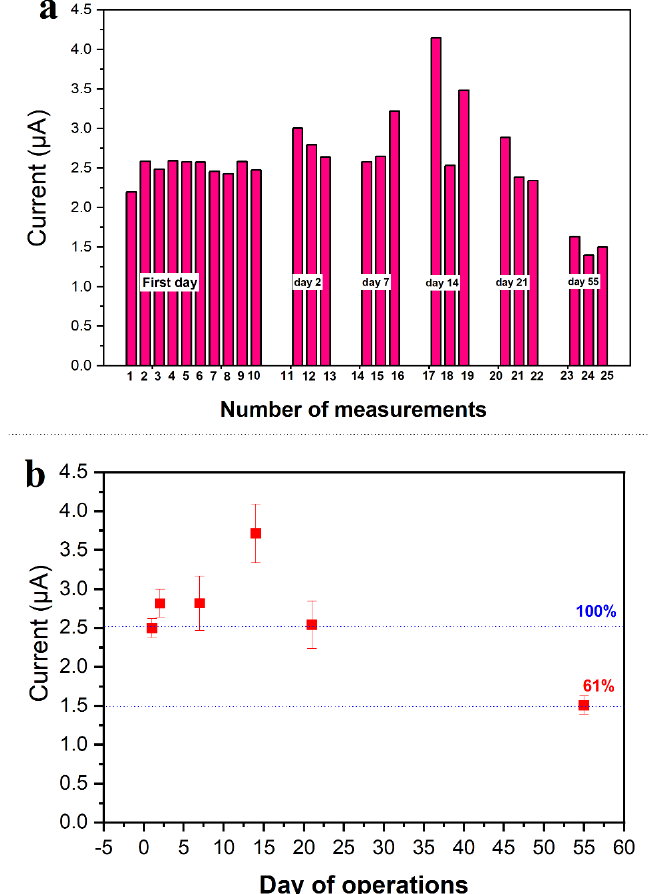
Figure 9. Stability of the TMAO biosensor. Current response for repetitive measurements with TorA-biosensor conducted during 2 months with the same sensor. ( a ) Current response of each measurement. ( b ) Average of the obtained current of each measurement day. Measurements were performed in Sörensen phosphate buffer pH 7 containing 1 mM MV and 3 mM glucose; addition of 1 mM TMAO and in each measurement; electrode modified with TorA (5.9 nmol/cm 2 ) covered by a membrane of GOx 10 U, Cat 1000 U, PVA 3%.